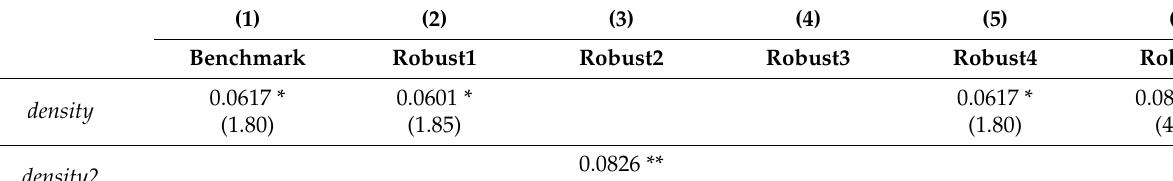
Table 3. Benchmark regression results: impact of density on credit